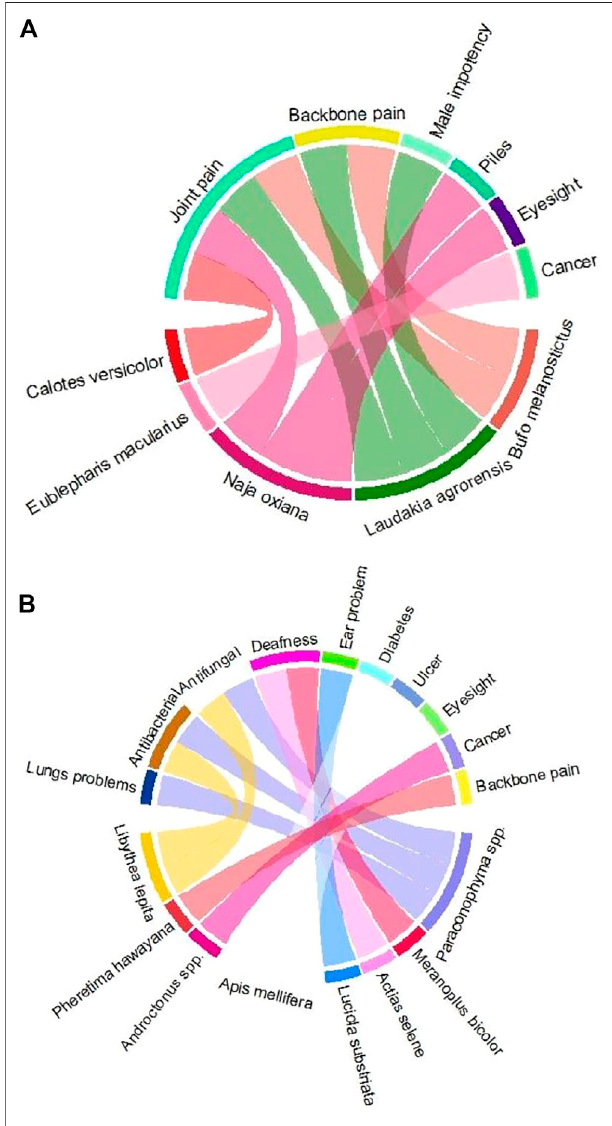
FIGURE 6 | Animal species distribution according to the treatment of variousailments in the Himalayan region of Azad Jammu and Kashmir. Animal species are classi fi ed into different groups such as (A) reptiles and (B)